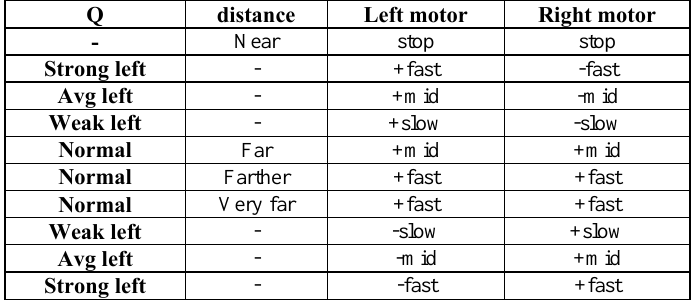
Fig. 6. Member function for the velocity of one of the motors (output) Table 1. Rules of the fuzzy logic controller (- corresponds to all the cases)